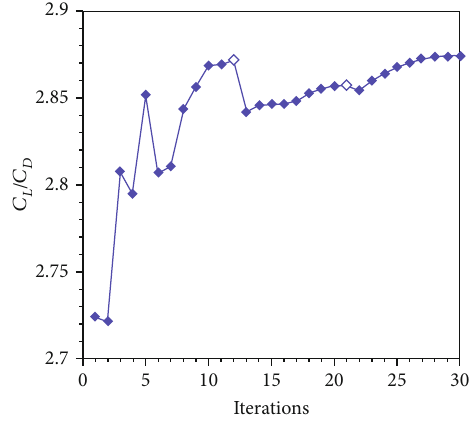
Figure 8: Optimization process. 1: Design variables of the